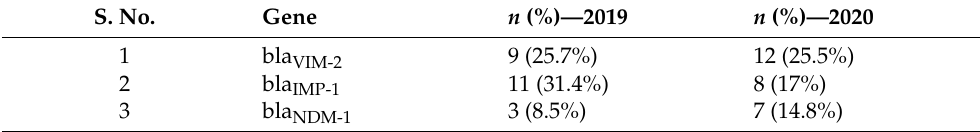
Table 4. Distribution of genes among clinical isolates of A. baumannii during 2019–2020. S. No. Gene n